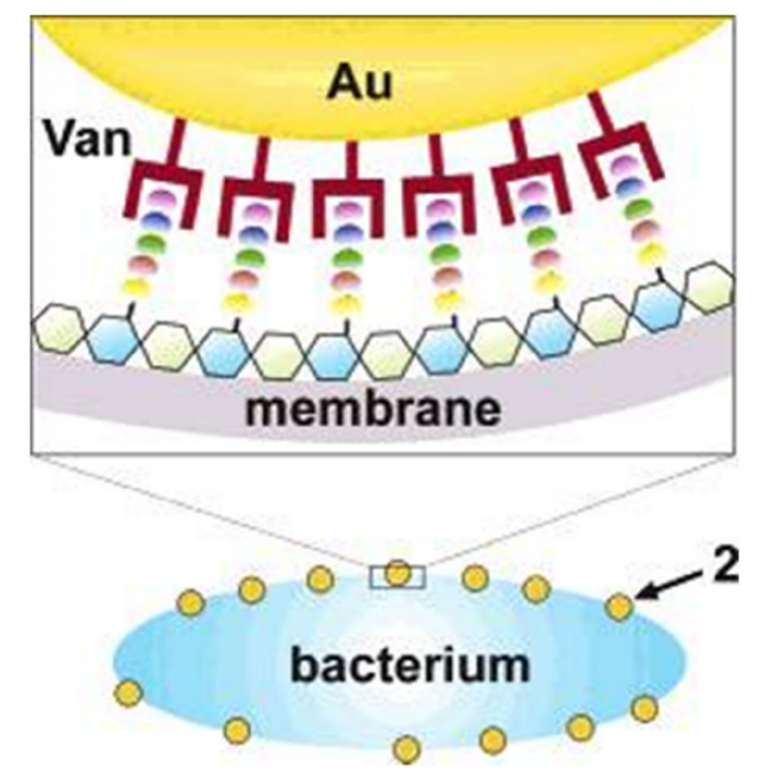
Figure 3. Vancomycin antimicrobial activity was capped to determine the MIC (minimum inhibitory concentration) for bacterial growth inhibition. The MIC dose of gold capped vancomycin was from 2 to 4 mg/m − 1 . In comparison, vancomycin alone showed a MIC of 64 mg/mL − 1 against a vancomycin-resistant enterococci bacterial strain. In addition, the functionalized nanomaterials were active against a strain of E. coli , but the antibiotic alone was not. In a reported study, an aminoglycoside antibiotic had the ability to absorb onto gold nanomaterials due to interactions between the antibiotic amine group and the gold surface [26].